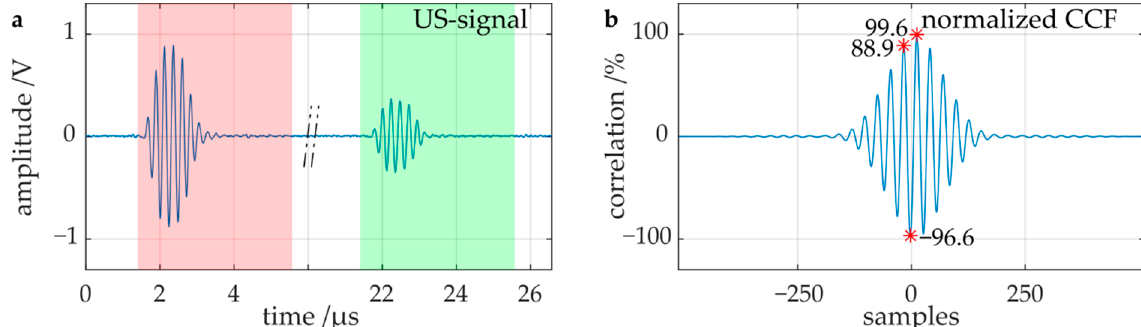
Figure 2. Illustration of the CCF of two ultrasonic echoes resulting from a sine-wave excitation. ( a ) Measurement of two backwall echoes of an ultrasonic wave in 60 mm steel, ( b ) CCF of the two echoes. The * markers highlight the extrema of the CCF.